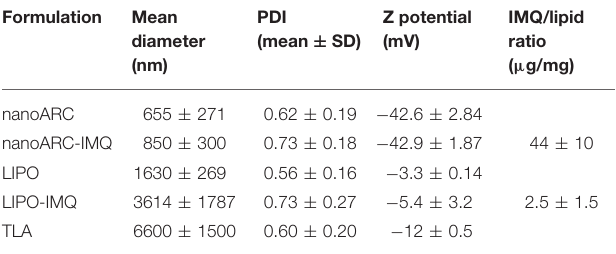
TABLE 1 | Structural characterization of